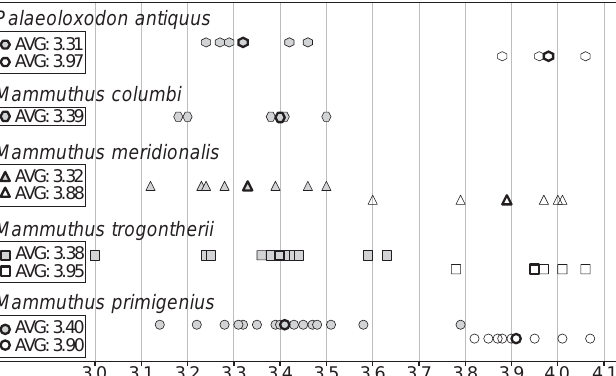
Fig. 4. Ulna lengths vs. skeletal shoulder height ratio of selected probosci- deans based on the data collected in this study (Appendix 1, SOM: table 2; AL unpublished data). The ratios shaded in grey correspond to the maximal length of the humerus, and the white ones to the articular length of the